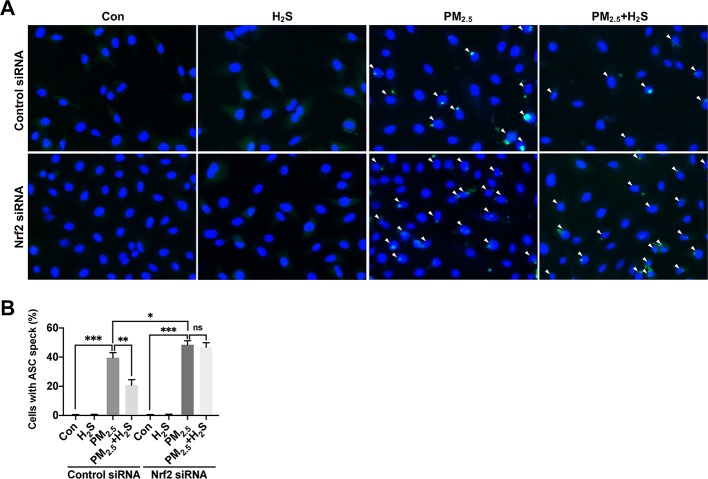
Effect of H2S on ASC speck formation in A549 cells after PM2.5 exposure. (A) Representative fluorescent images of Hoechst (blue) and ASC (green) merge in control, H2S, PM2.5, PM2.5+H2S group in control small interfering RNA (siRNA) or Nrf2 siRNA transfected A549 cells respectively (×400). (B) Percentage of ASC speck positive cells (white arrow) in each group respectively. Results are expressed as mean ± SD; three independent experiments were done in each group. ns p > 0.05, *p< 0.05, **p < 0.01, ***p < 0.001 between groups. Nrf2, nuclear factor erythroid 2 related factor 2; H2S, hydrogen sulfide; PM2.5, fine particulate matter; ASC, apoptosis-associated speck-like protein.